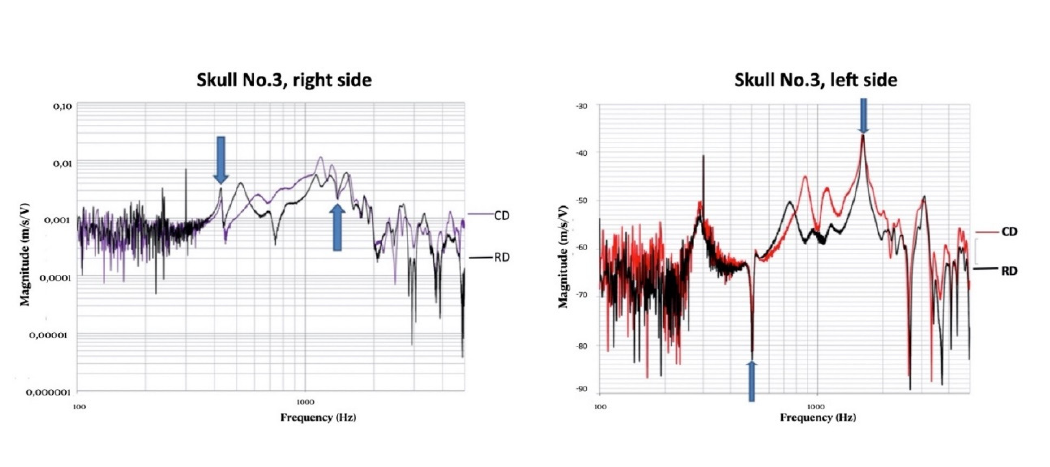
Figure 4. Vibration velocity in CD vs. RD and TJ vs. RD. The “ranges of di ff erences” were